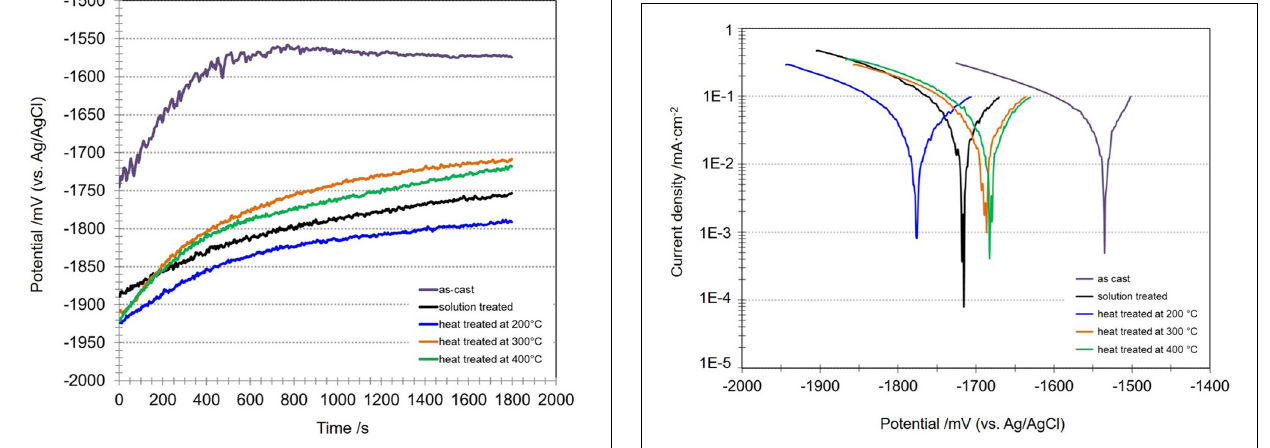
FIGURE 5 | Potentiodynamic polarization measurements of as-cast, solution treated, heat treated at 200 ◦ C, 300 ◦ C, and 400 ◦ C of Mg-10Gd alloy in 0.5 wt.% NaCl solution after 30 min OCP at room